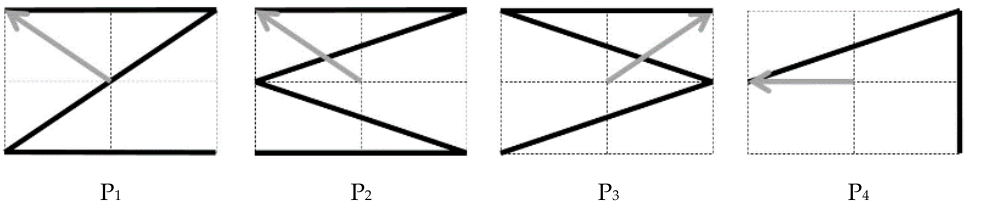
Figure 6. Four different eye-gaze patterns used for the experiment.